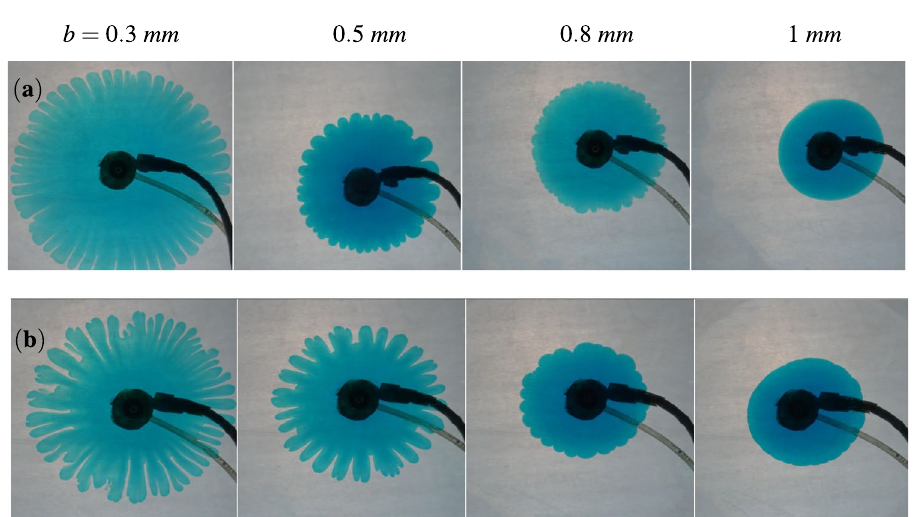
Figure 2. Consequences of changing the gap and the log-mobility ratio. The dynamics are shown at t = 15 s for Q = 0.1 mL/s and ( a ) M = 2 , ( b ) M = 3 . As we move from left to right in each row, the gap